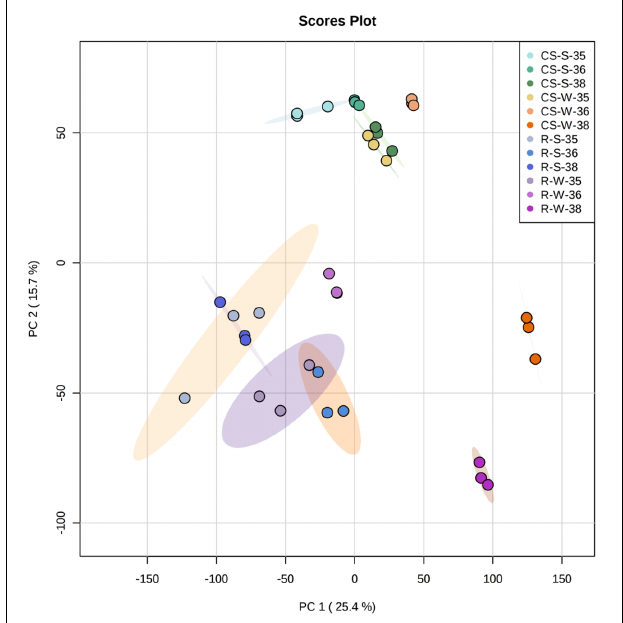
FIGURE 5 | Principal component analysis of the whole normalized gene expression dataset. Four different colors (one per each type of sample: CS-W, CS-S, R-W, R-S) and then for each color three different tones (35, 36, and 38 EL stages) were used to represent different samples. Ellipses encircle the three replicates of each sample subjected to the same stage. CS/R, “Cabernet Sauvignon”/“Riesling”; S/W, summer/winter